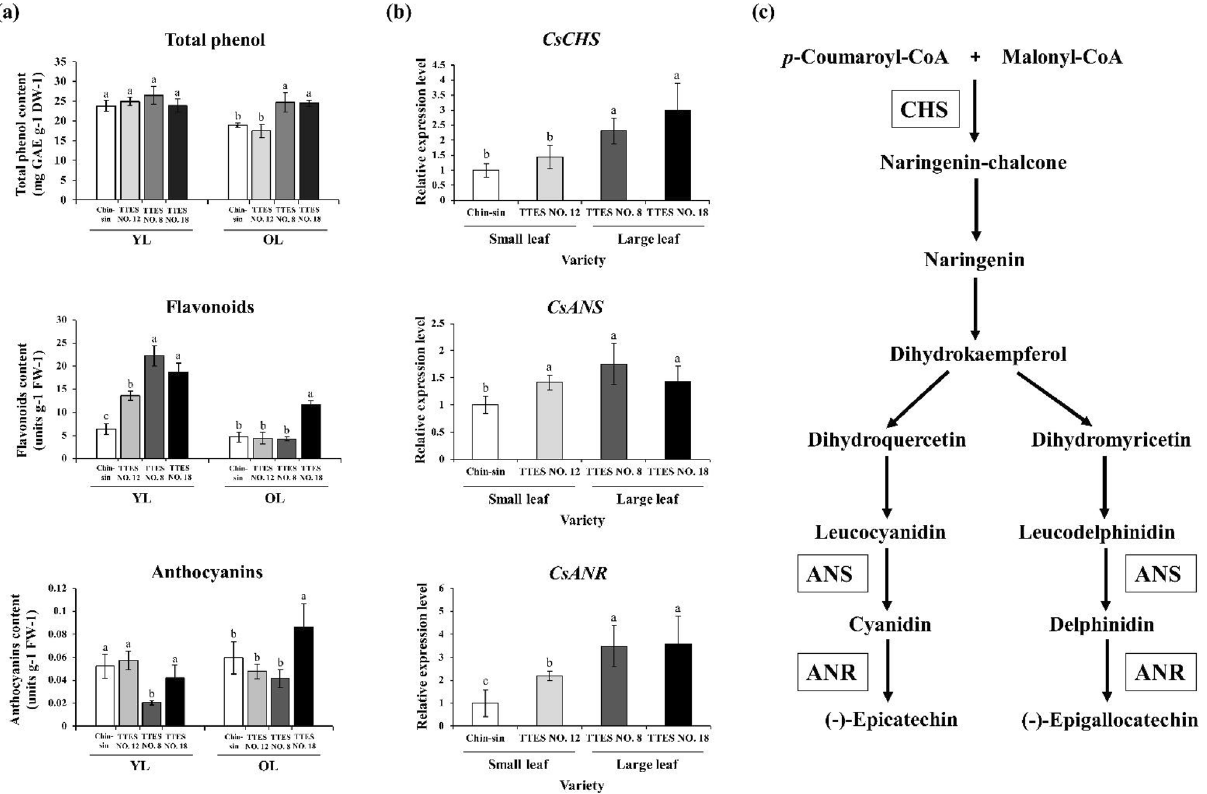
Figure 5. Comparison of secondary metabolite contents and transcript levels of flavonoid biosynthesis–related genes in small- and large-leaf varieties. ( a ) Contents of total phenol, flavonoids, and anthocyanins in the young and old leaf tissues of different tea varieties. ( b ) Transcript levels of CsCHS , CsANS , and CsANR in the young leaf tissues of different tea varieties. Transcripts levels were measured using qRT-PCR and normalized to that of 18S rRNA. ( c ) The flavonoid biosynthesis pathway in tea. Values are presented as the mean ± SD of three biologically independent experiments. Different letters indicate significant differences between varieties assessed using the LSD post-hoc test ( p < 0.05). ANS anthocyanidin synthase; ANR anthocyanidin reductase; CHS chalcone synthase; DW dry weight; FW fresh weight; GAE gallic acid